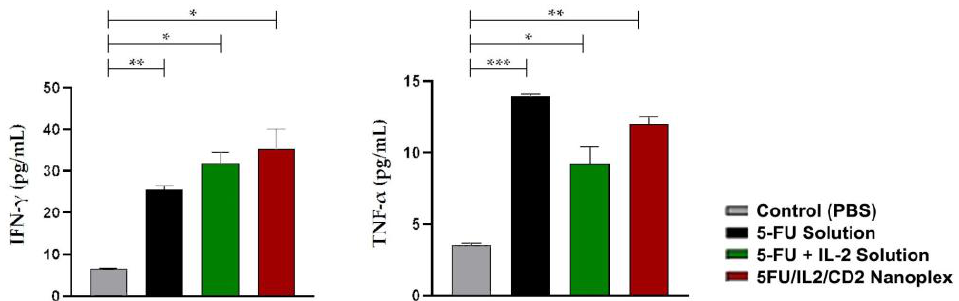
Figure 11. The analysis of T lymphocyte-related proinflammatory cytokine level in serum (* p < 0.05, ** p < 0.01, *** p < 0.001).